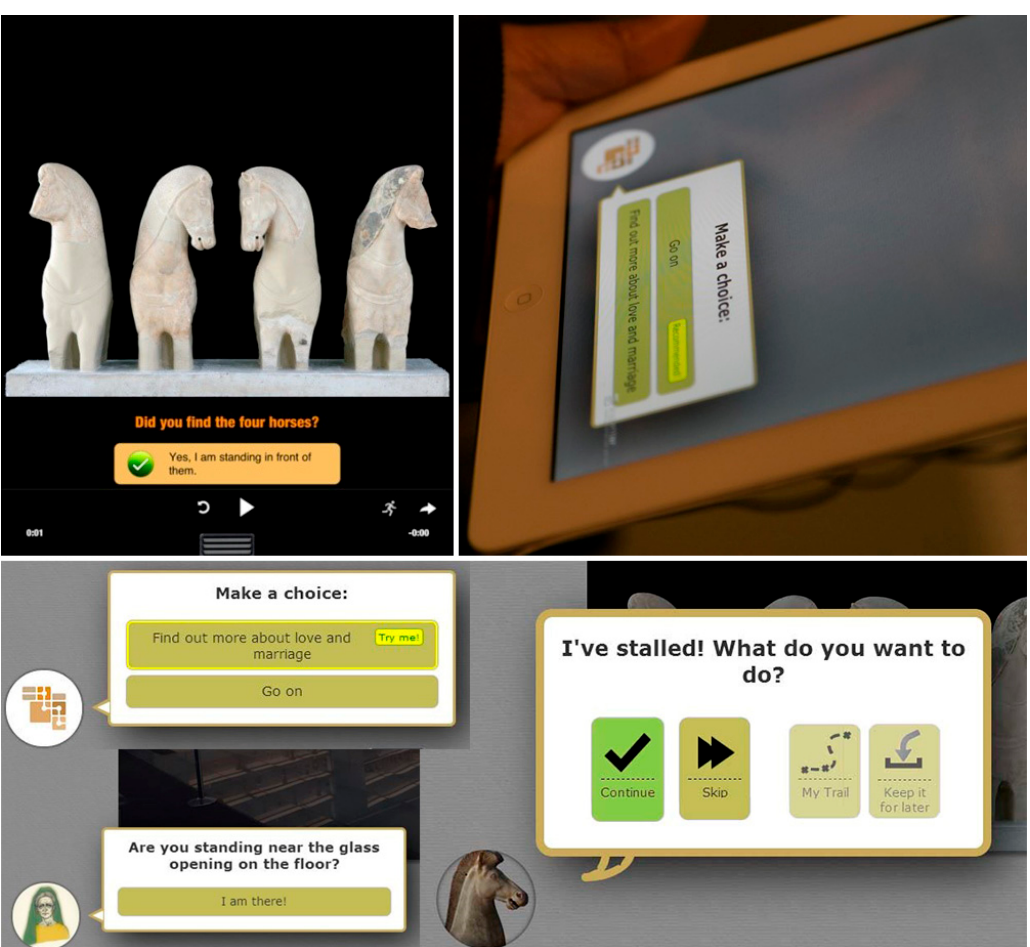
Figure 5. Screenshots showing the approaches to wayfinding and interaction: control points to ensure that the visitor is in the right place for the story to continue and branching points with recommendations for choices that the system considers would interest the specific user and detours or functionalities for pausing, skipping, or saving for later.